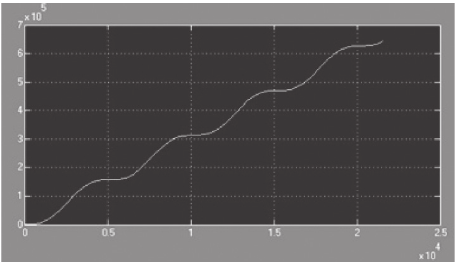
Fig. 3. The time variation of the error of the traversed path of one channel when the gyro drifts with angular velocity ω_qp0 = 0.1 grad/st